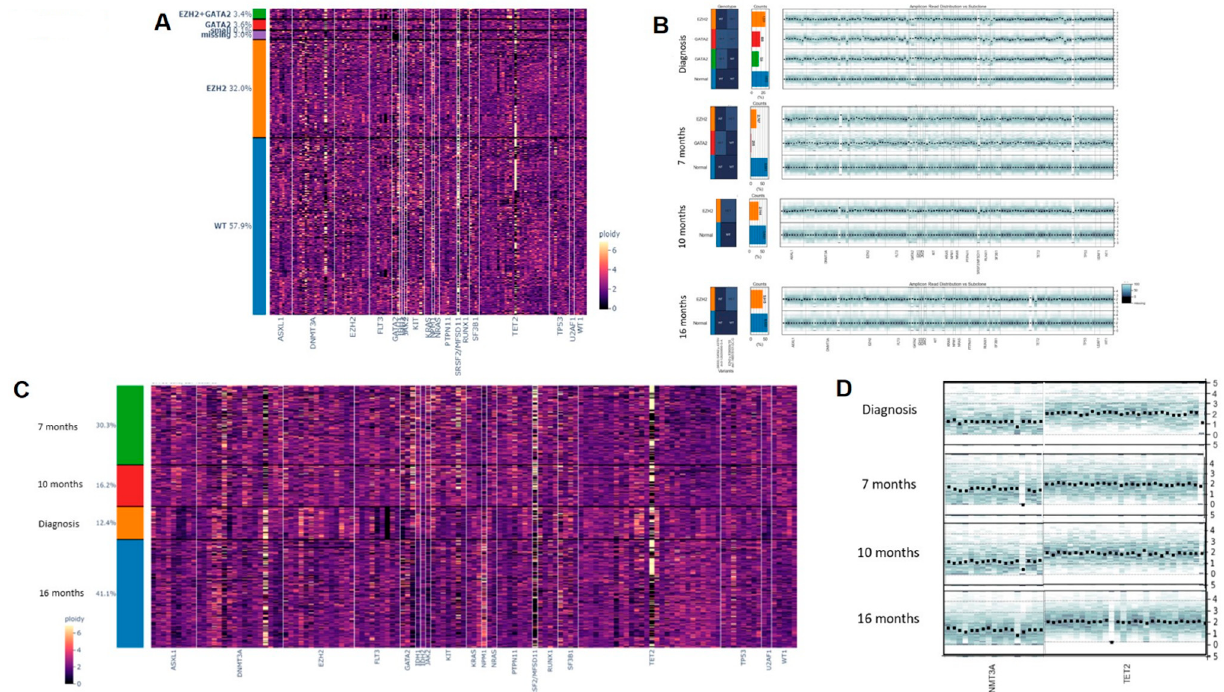
Figure 6. Co-occurrence of SNVs and short INDELs with CNVs in Patient 2 as independent cell clones. ( A ): merged CNV analysis of all time points; ( B ): CNV analysis at individual time points in association with GATA2 p.A372V and EZH2 p.R369Sfs*55 mutations; ( C ): Unbiased clustering of CNV analysis of all time points; ( D ): Gradual copy number loss of DNMT3A and TET2 at 7 months (before the first cycle of AZA), at 10 months (after 3 cycles of AZA), and at 16 months (at progression to secondary AML after 9 cycles of AZA).